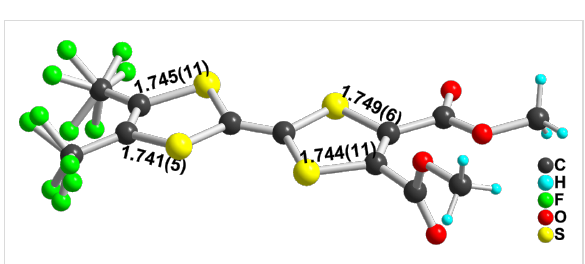
Figure 6: View of the 3bc molecule. Note the disordered CF 3 groups as well as the CO 2 Me group orthogonal to the TTF plane.